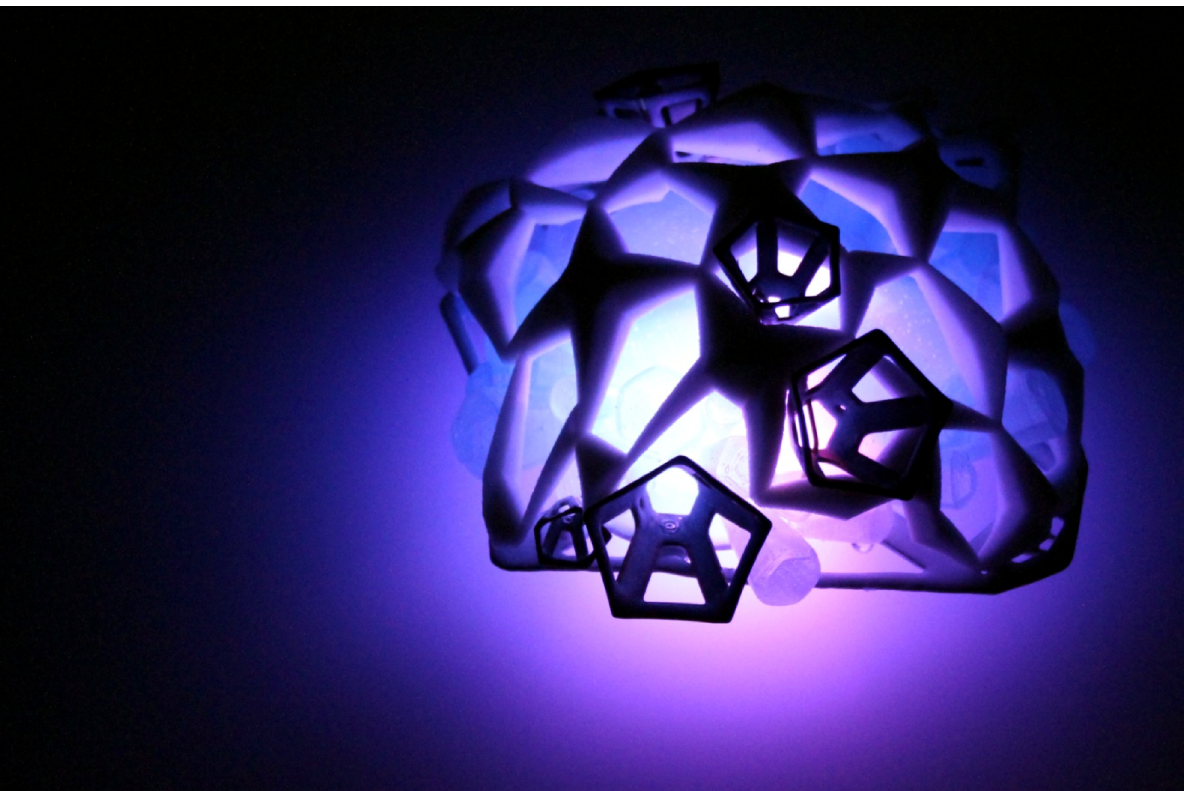
Figure 12 | Geotronic Brooch in its active state, Katharina Vones